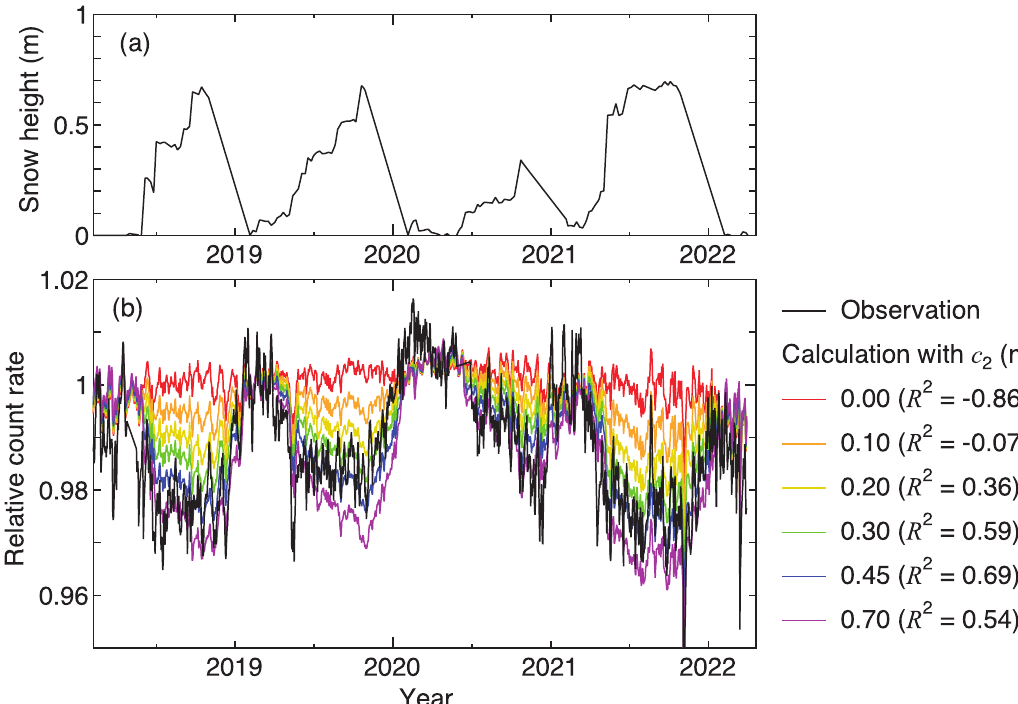
Figure 2. Observed snow cover depth (top panel) and the pressure-corrected relative count rates of the neutron monitor as obtained from the observation and the PARMA calculation with different c 2 parameters (bottom